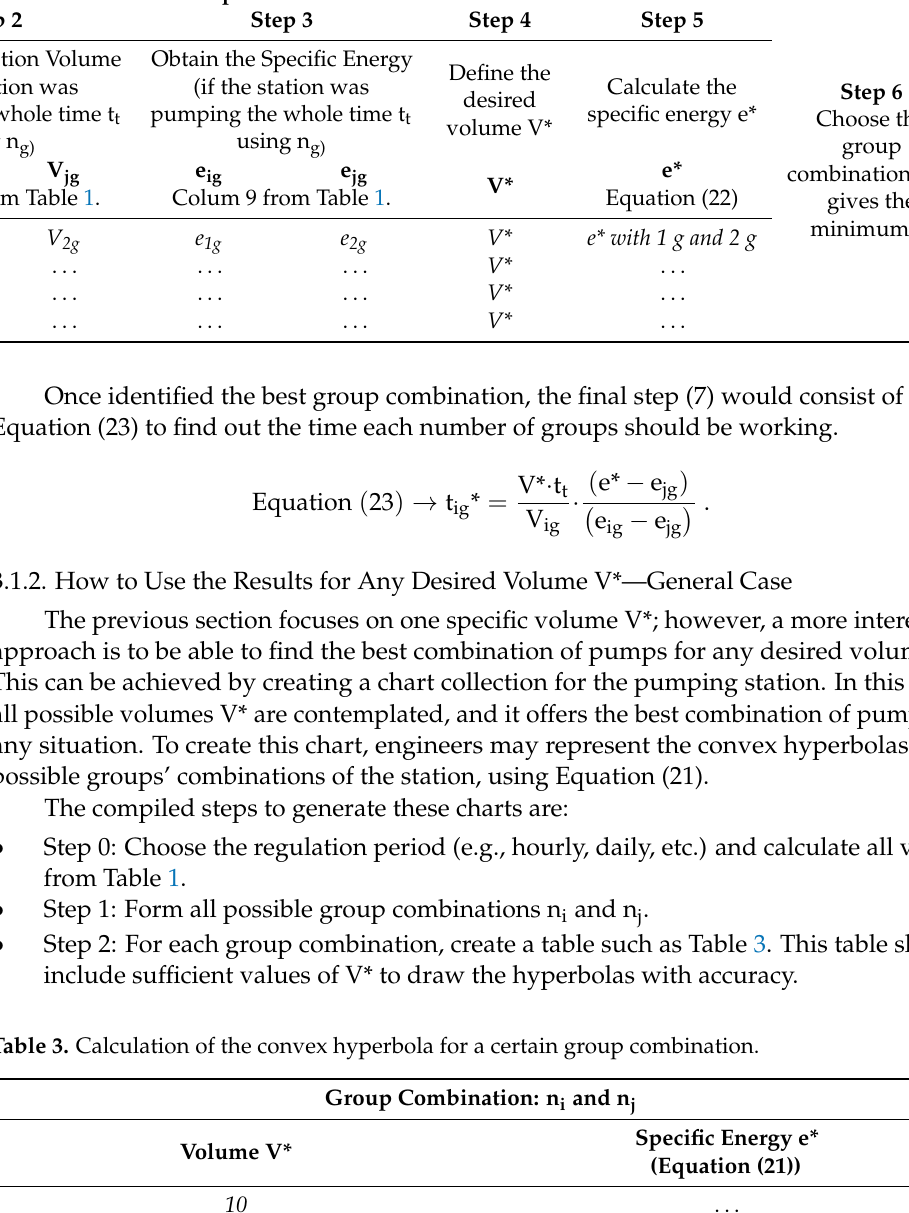
Table 2. Steps to select the group combination for a certain volume V*.